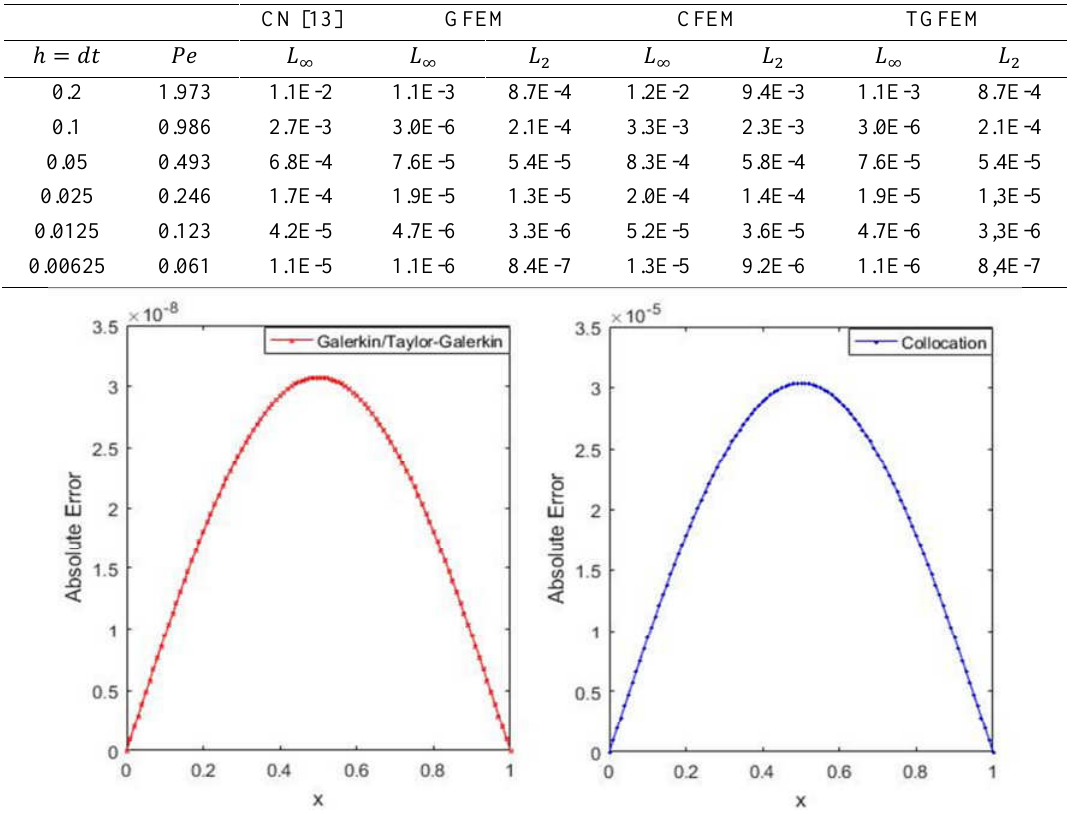
Figure 3. Comparison of the absolute errors of the Galerkin and collocation schemes for (cid:10) (cid:2) 0.01 (cid:12) , (cid:13)(cid:14) (cid:2) 0.0001 (cid:15) and